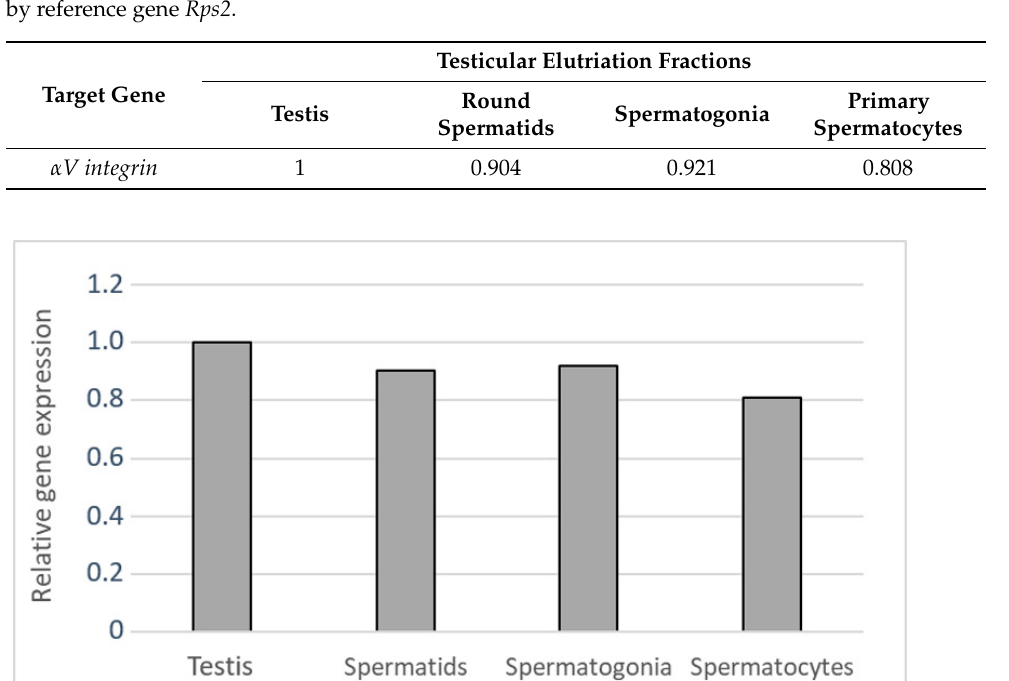
Figure 2. Gene expression of α V integrin in the mouse testicular elutriation fractions enriched with round spermatids (Spermatids), spermatogonia, and primary spermatocytes (Spermatocytes).